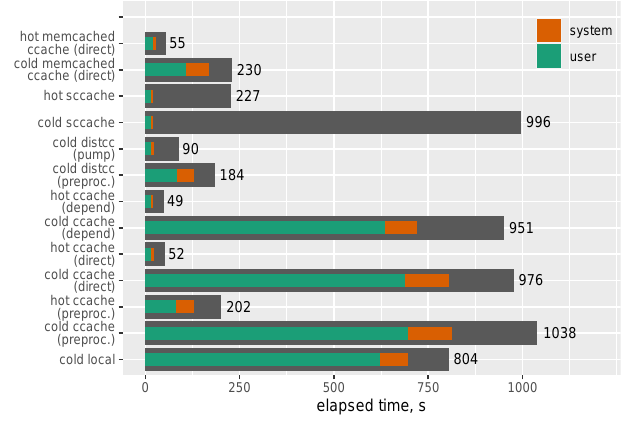
Figure 5. Elapsed time in seconds of all performed benchmarks. The user and system CPU time normalised to the number of cores (4) are shown with green and red, respectively. Cold (hot) signifies a build with 0% (100%) cache